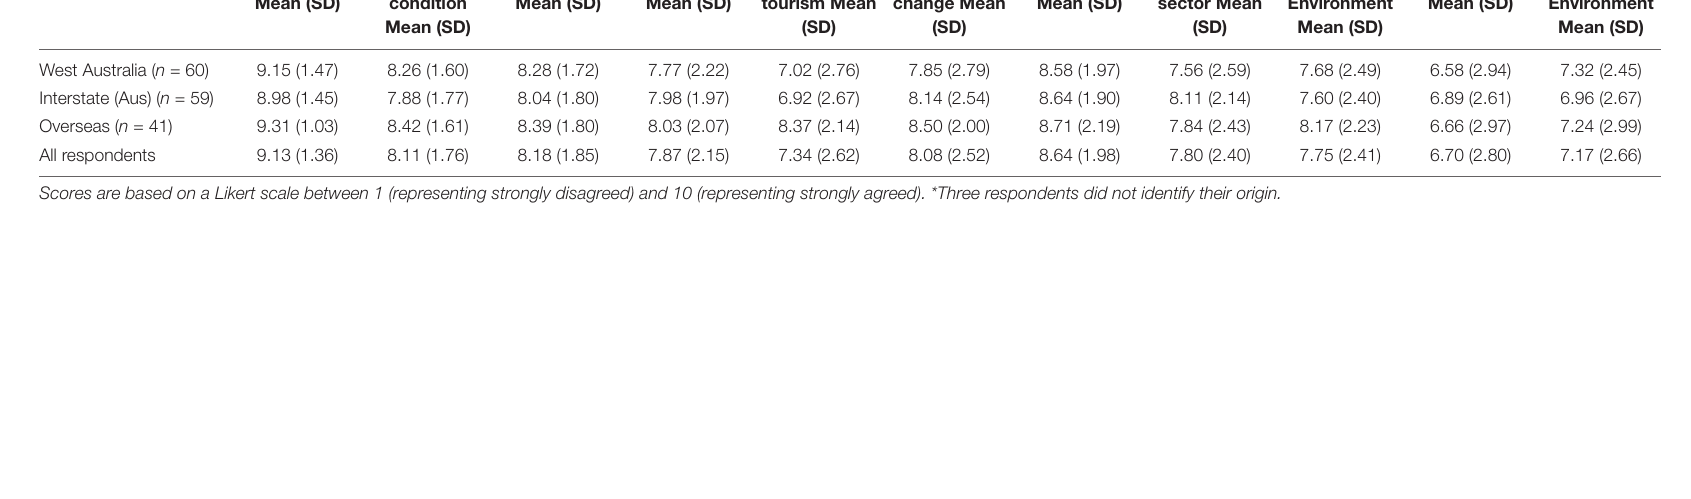
TABLE 2 | Visitors’ perceptions of the Ningaloo Coast WHA, and concerns for its future. Visitor origin ( n = 160)* WHA lives up to expectation